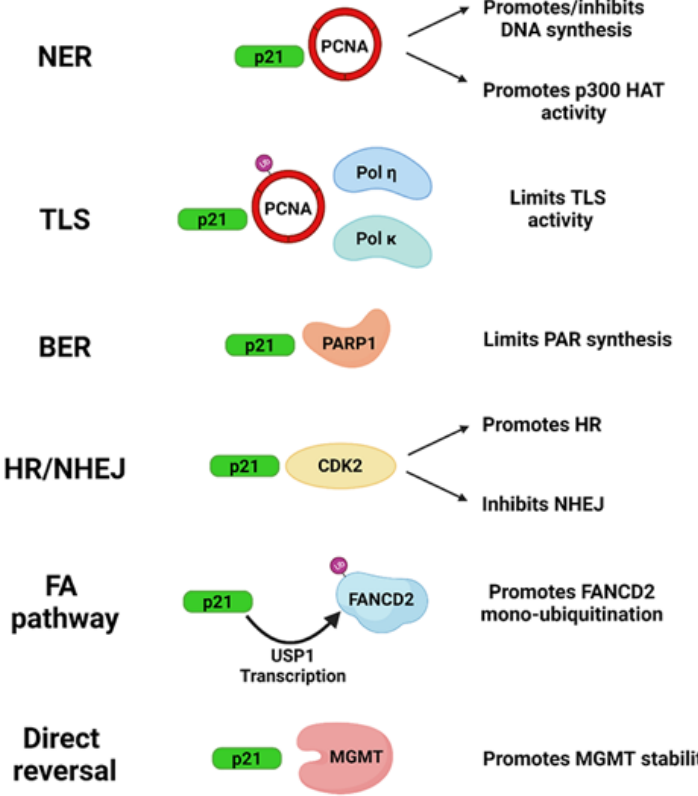
Figure 2. Schematic model summarizing the influence of p21 on DNA repair systems. Created with BioRender.com (Toronto, ON, Canada) (accessed on 10 May 2022). https://biorender.com/